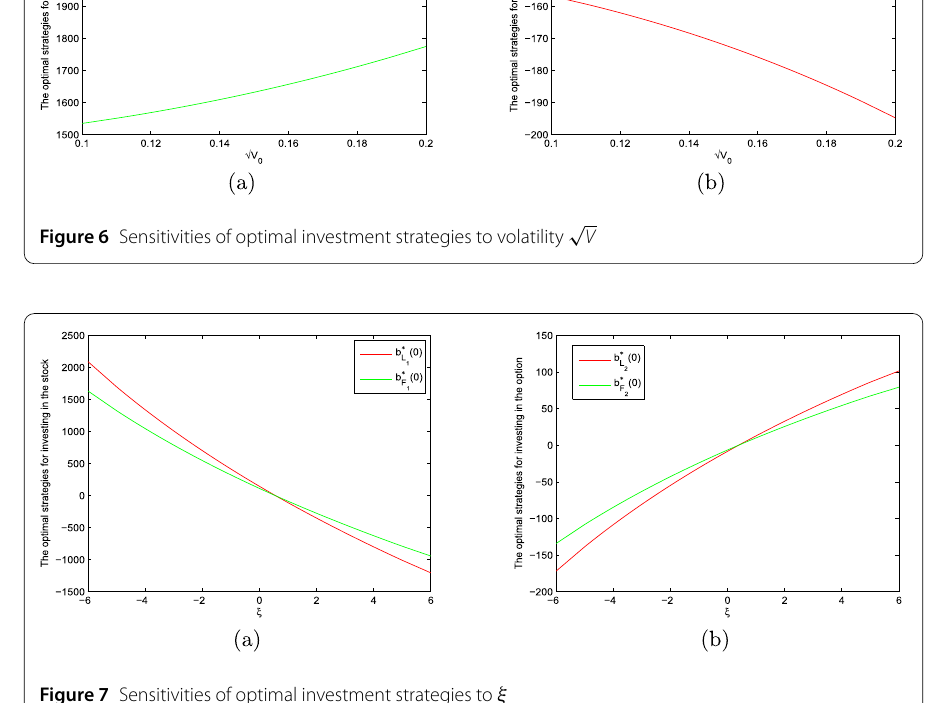
Figure 7 Sensitivities of optimal investment strategies to